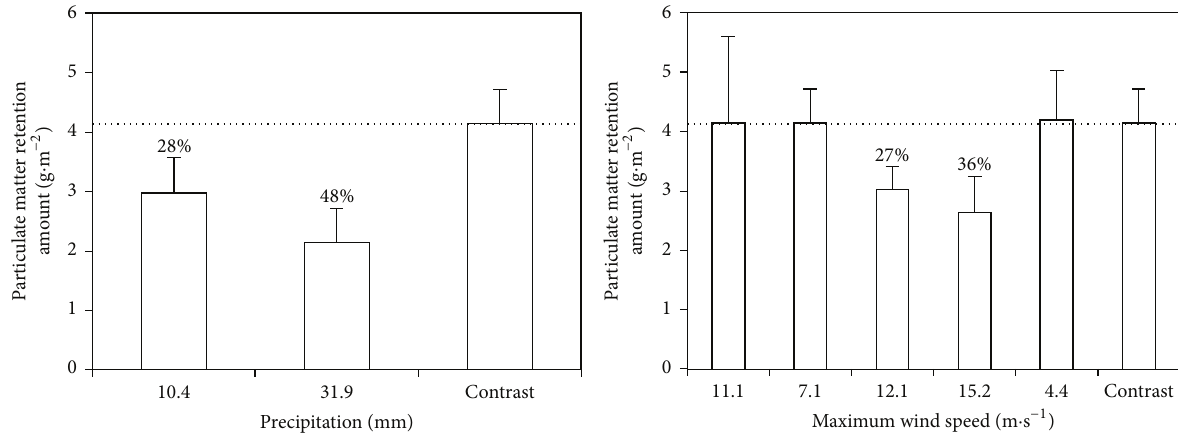
Figure 5: The effects of precipitation (mm) and maximum wind speed (m ⋅ s −1 ) on leaf PM retention amounts (g ⋅ m −2 , data are mean ± SD).